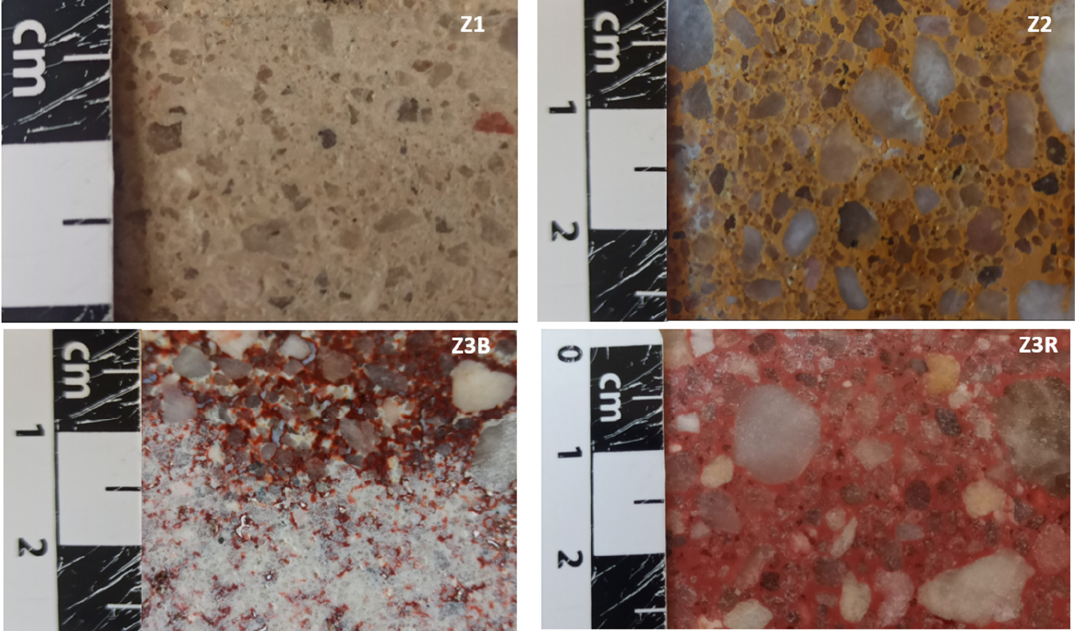
Figure 1. Macroscopic view of the Zamora Building Stones. ( Z1 ) white stone, silicified microconglomerate. ( Z2 ) ochreous stone, silicified conglomerate. ( Z3B ) white and red stone, silicified conglomerate. ( Z3R ) purple stone, silicified conglomerate.